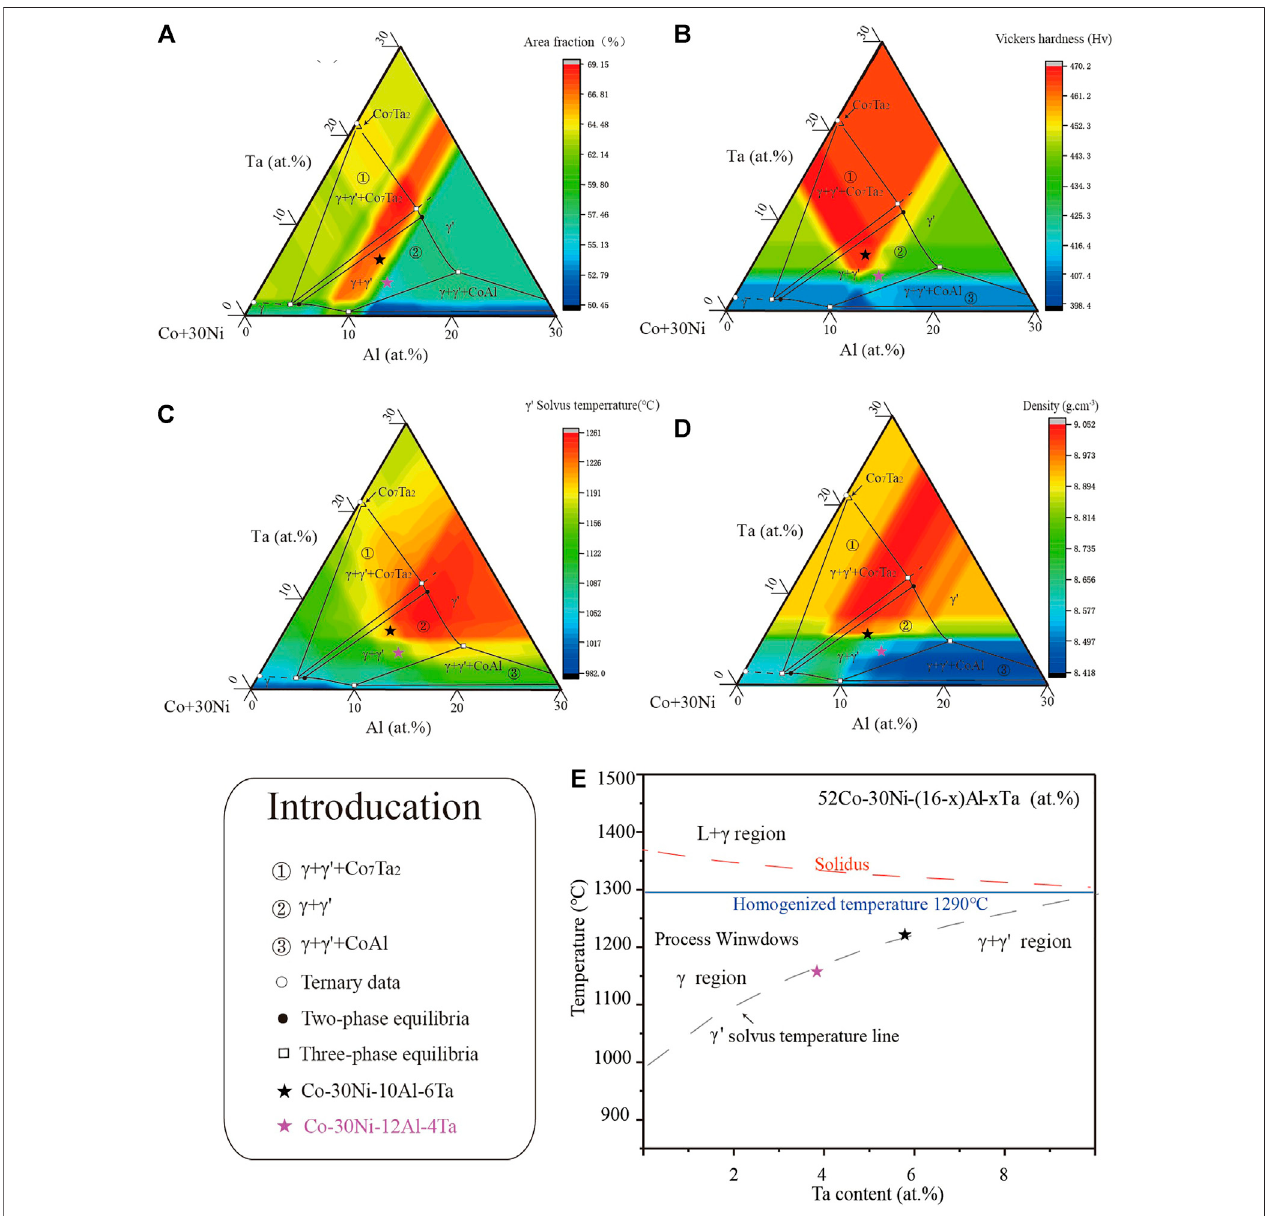
FIGURE1| Relationimagebetween (A) γ ′ areafraction, (B) Vickershardness, (C) γ ′ solvustemperature, (D) density,and (E) phasetransformationtemperatureline and pseudo-ternary isothermal section diagram of the Co-30Ni-Al-Ta quaternary system at 800 ° C based on machine-learning method calculation.